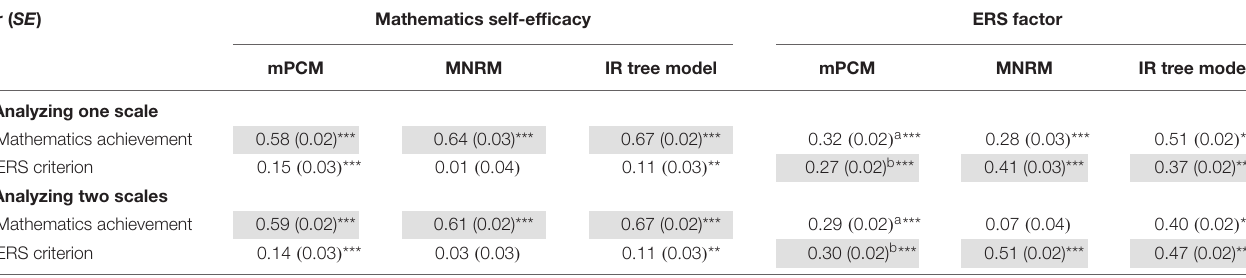
TABLE 9 | Relationships of criteria with the factors of IRT models in Study 2. r ( SE ) Mathematics